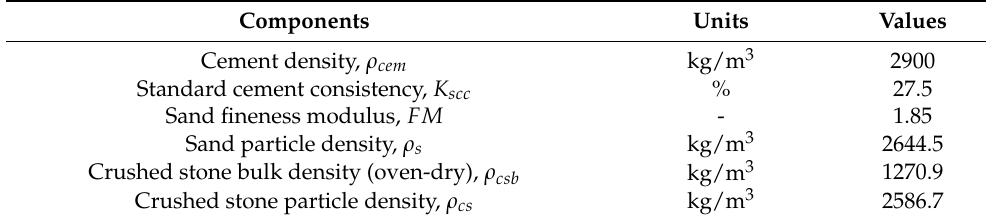
Table 1. Concrete component properties.